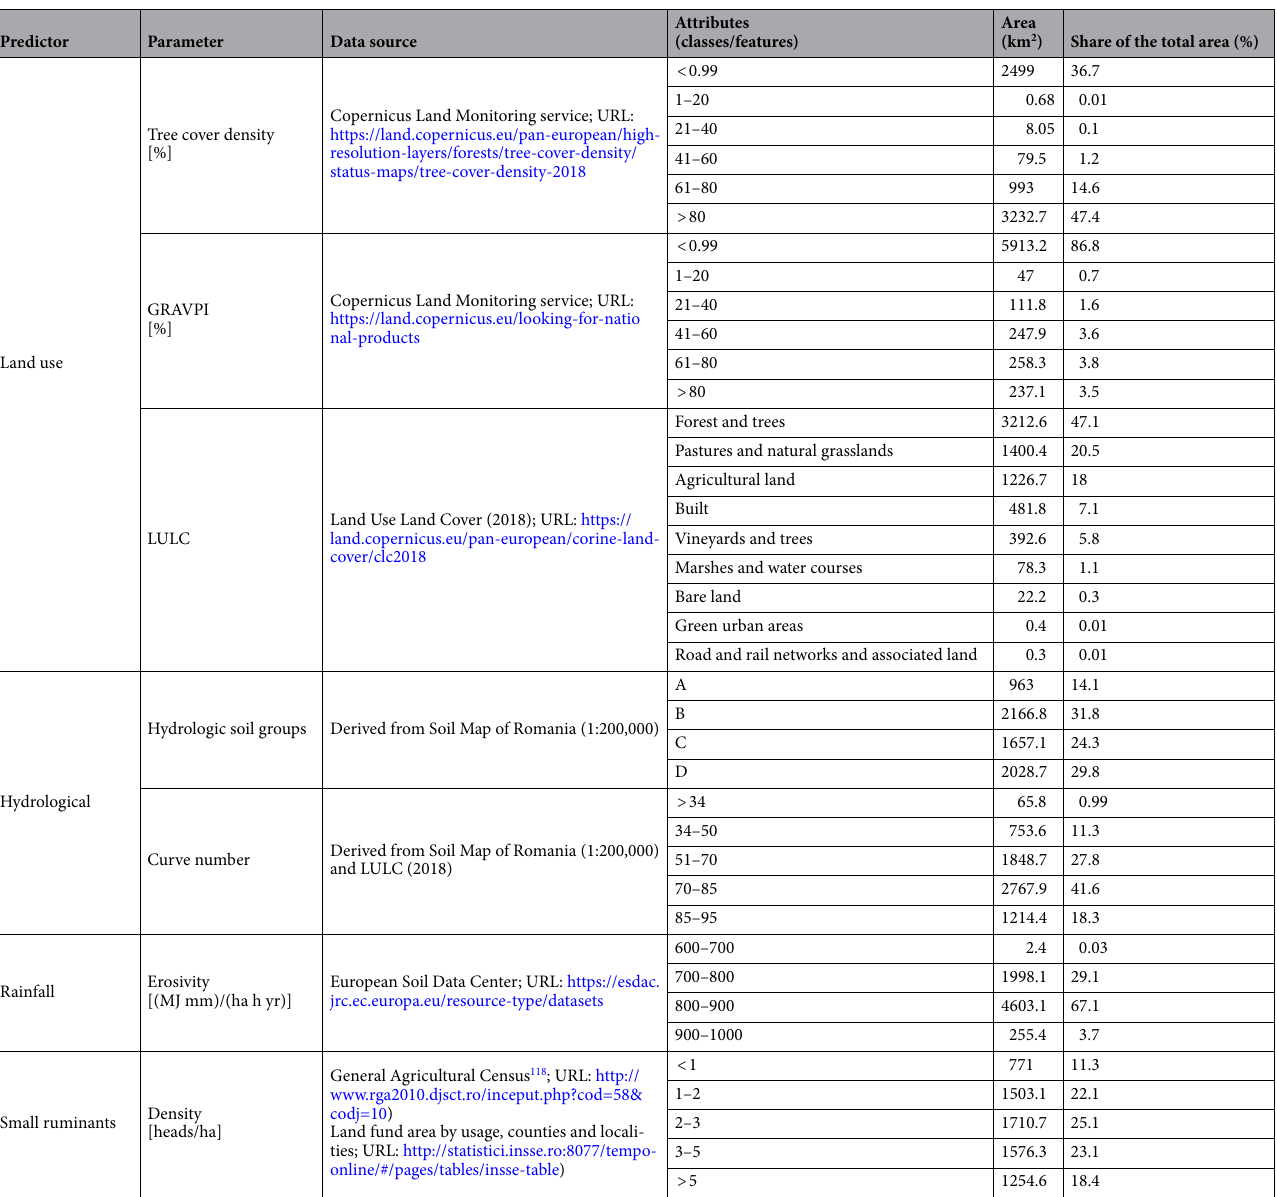
Table 1. Parameters used for training the sampling points. GRAVPI grassland vegetation probability index, LULC land use land